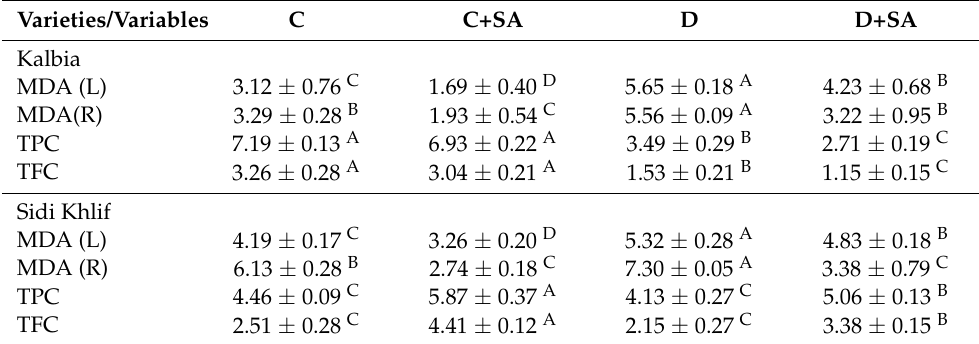
C treatment (control: 50 µ M Fe); D treatment (Deficient: 1 µ M Fe); SA (Salicylic acid: 0.25 mM). L—leaves; R—roots. Data are means of 4 replicates ± SE. Means in the same line followed by distinct letters are